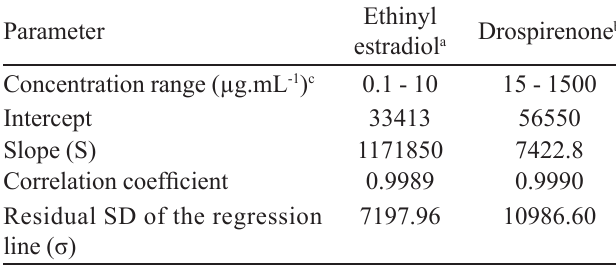
TABLE I - Statistical data from the analytical curve for the proposed HPLC method